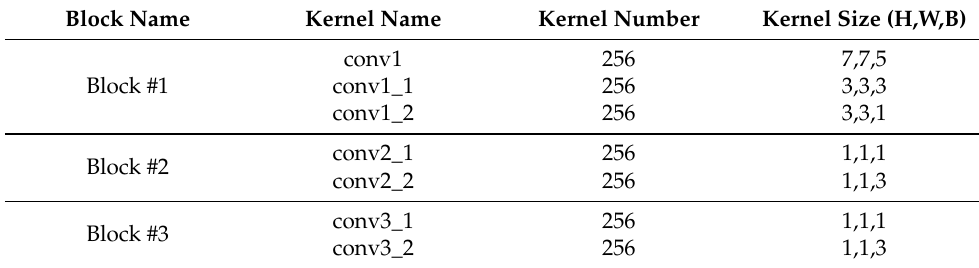
Figure 4. The backbone’s structure in the Siamese 3D CNN branch. Table 1. The convolutional layers’ parameter in the Siamese 3D CNN’s